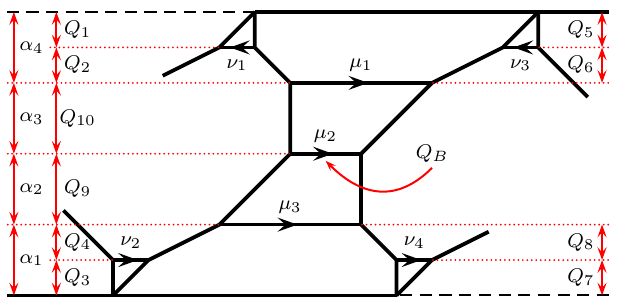
Figure 8. 5-brane web diagram for SO(8) theory with a Z 2 twist where we first couple four auxiliary spinors and then later decouple all the spinors after obtaining the partition function. In this way, one can compute the partition function for 6d SO(8) theory with a Z 2 twist.